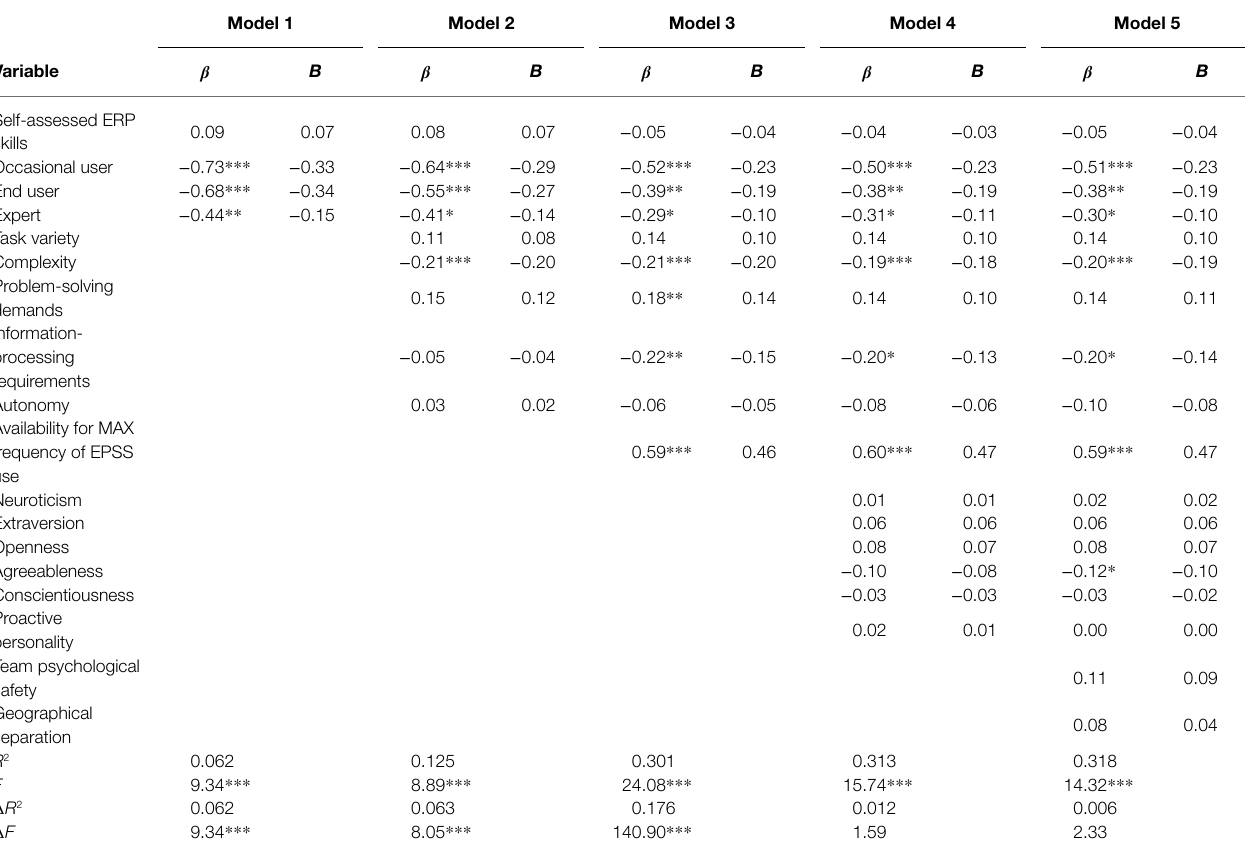
TABLE 6 | Hierarchical multiple regression analysis summary for the MAX frequency of EPSS